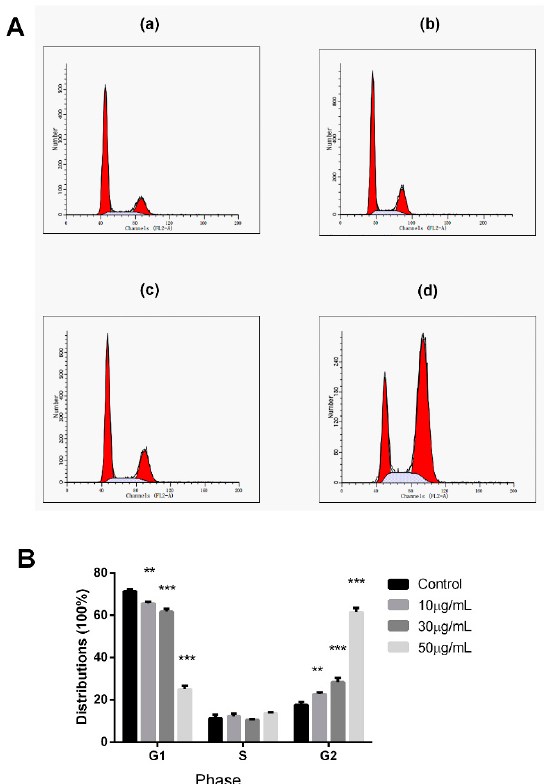
Figure 5. Analysis of cell cycle distributions. ( A ) PC-3 cancer cells were untreated ( a ) or treated with peperomin E ( b , 10 µ g / mL; c , 30 µ g / mL; d , 50 µ g / mL) for 72 h, then analyzed by flow cytometry. ( B ) The distribution and percentage of cells in G1, S and G2 / M phase of the cell cycle are indicated. Data are presented as means ± SD ( n = 3). * P < 0.05, ** P < 0.01, *** P < 0.001 versus